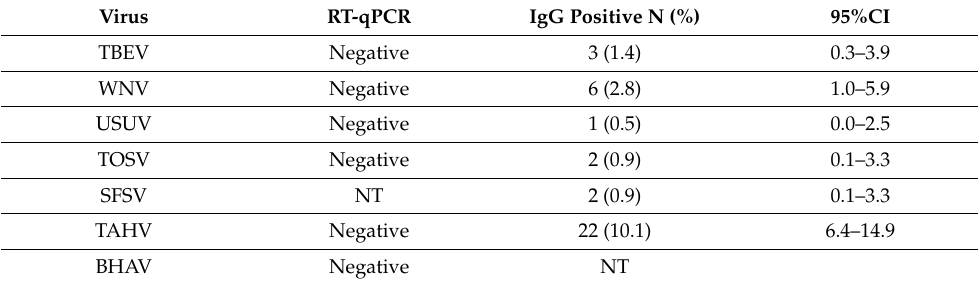
Table 2. Seroprevalence of arboviruses in patients with neuroinvasive disease (N = 218).